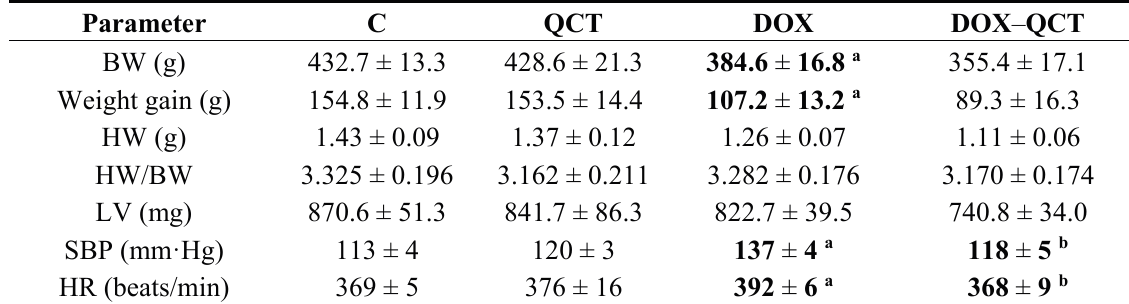
Table 1. Effects of quercetin on biometric parameters in normal and doxorubicin-treated rats. BW, body weight; HW, heart weight; LV, left ventricle; SBP, systolic blood pressure; HR, heart rate; C, control rats; QCT, quercetin-treated rats; DOX, doxorubicin-treated